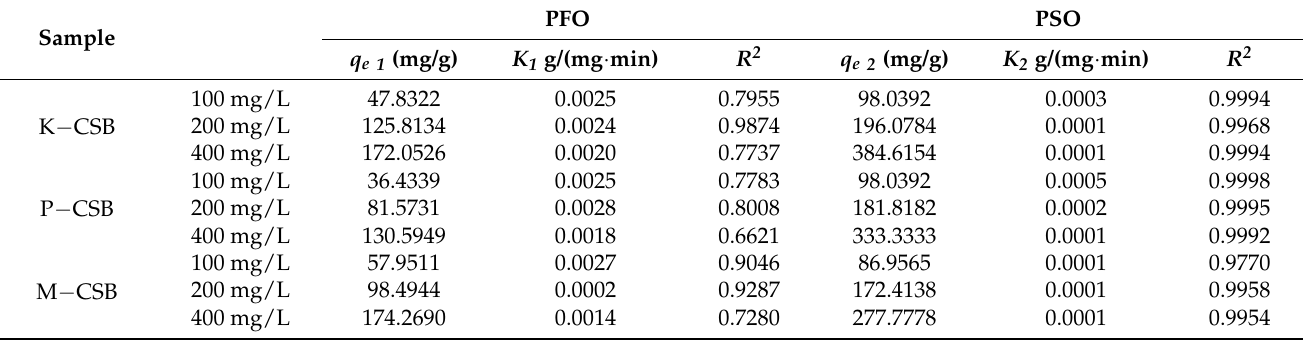
Table 3. The adsorption kinetic parameters of TC adsorption on modified carb shell